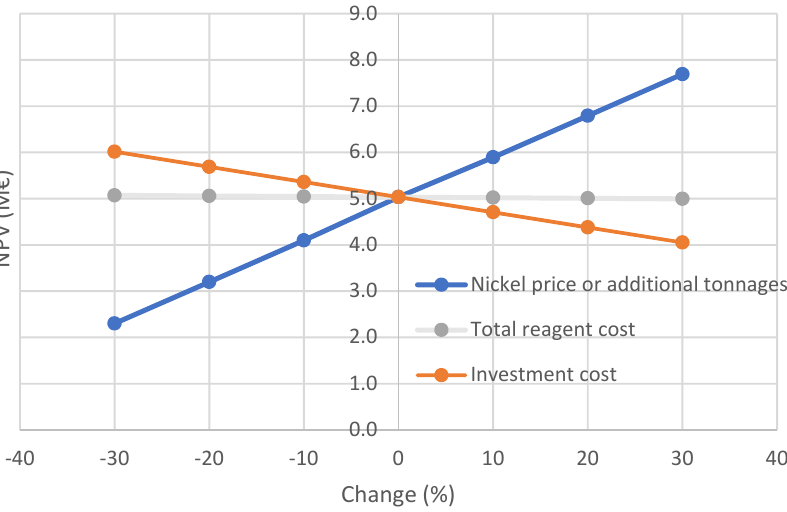
Figure 7. Sensitivity of the NPV calculation.